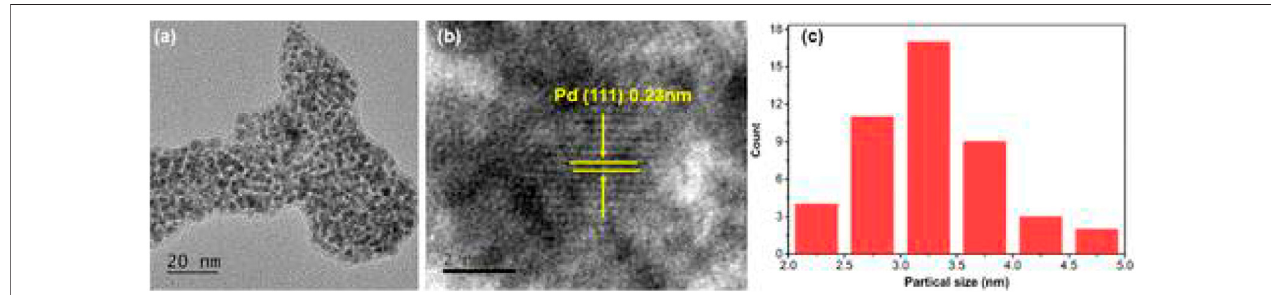
FIGURE 7 | (A) TEM and (B) HR-TEM images of Pd@CD-CONH and (C) histogram. (Reproduced from Selim et al., 2020, American Chemical